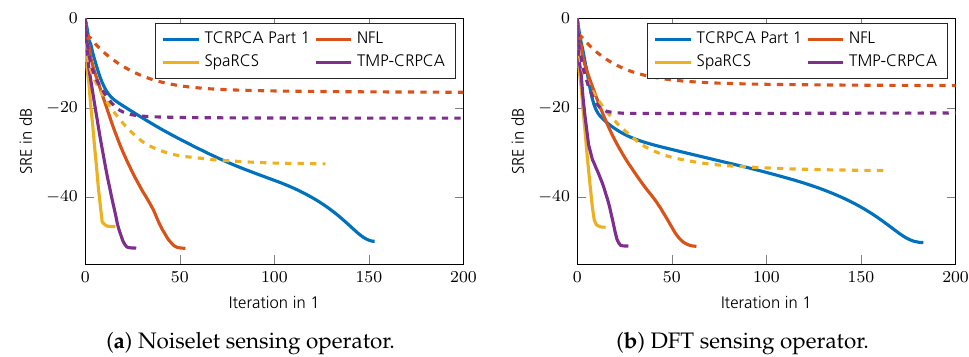
Figure 18. Comparison of convergence speed for ρ = 3, κ / m = 0.2 and m / n = 0.8. The solid lines show NFL, SpaRCS, and TMP-CRPCA for K = κ and R = ρ and the dashed lines for K = 2 κ and R = 2 ρ .